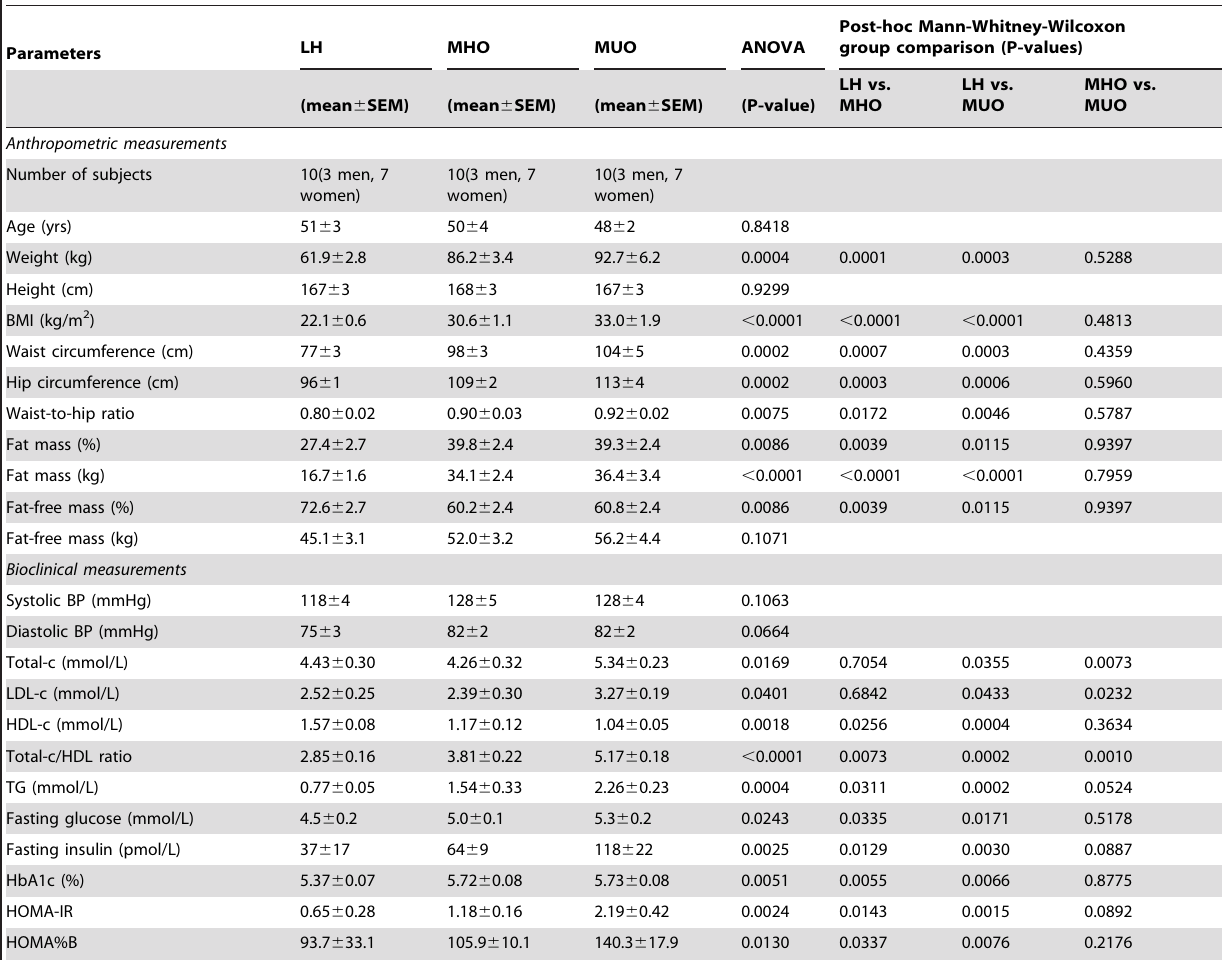
Table 1. Study population